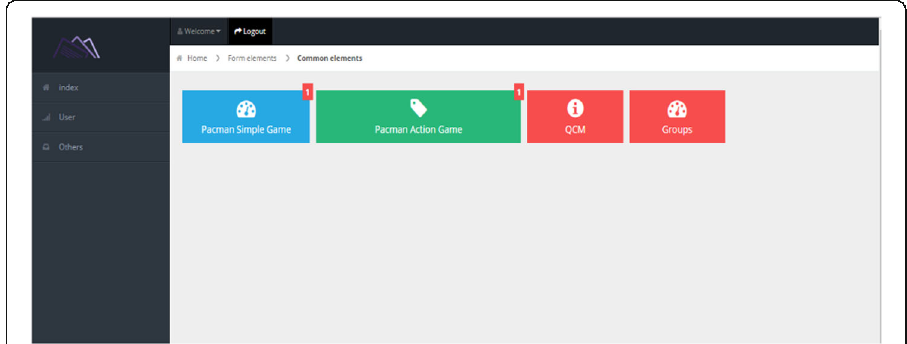
Fig. 4 Menu of the Web application for playing open educational